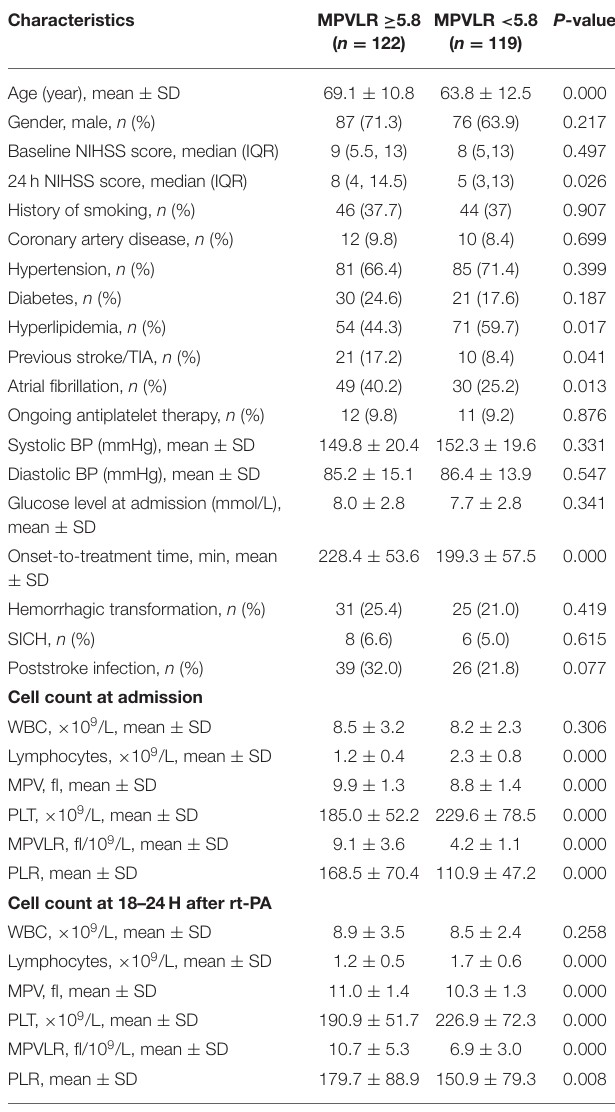
TABLE 2 | Receiver operating characteristic curves identifying the predictive value of PLR and MPVLR for poor outcomes at 3 months.